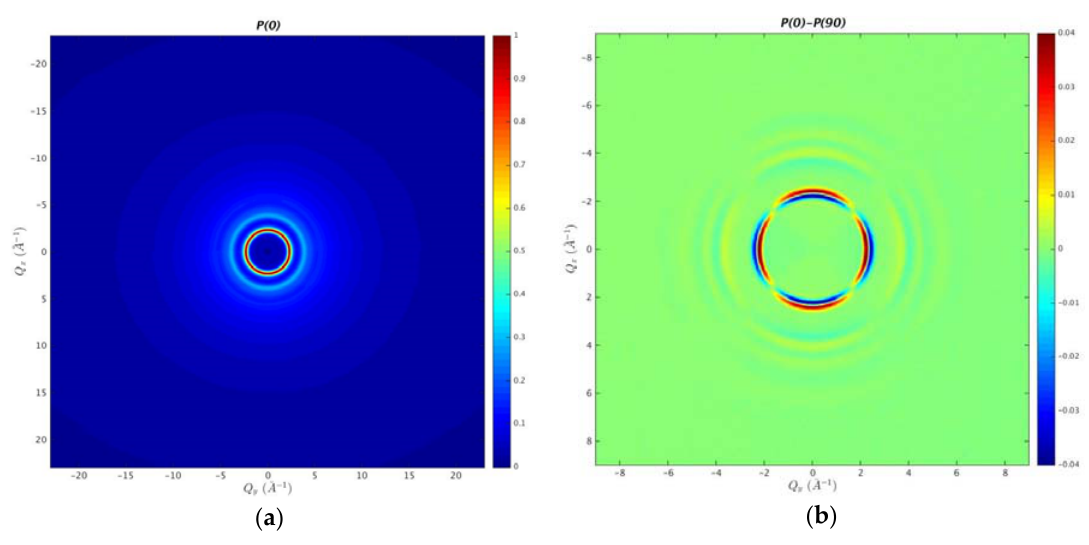
Figure 1. ( a ) High ‐ energy X ‐ ray diffraction pattern from metallic glass Zr 55 Cu 30 Ni 5 Al 10 , colors indicating intensity; ( b ) Difference between Data Set #1 (the stress axis vertical) and Data Set #2 (stress axis horizontal).